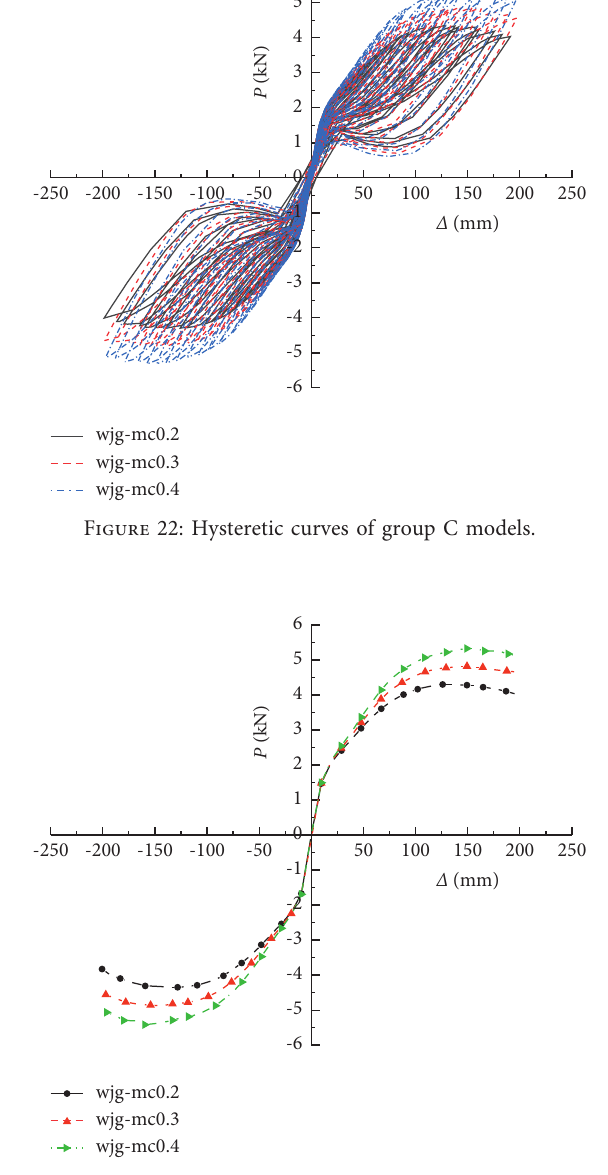
Figure 23: Skeleton curves of group C